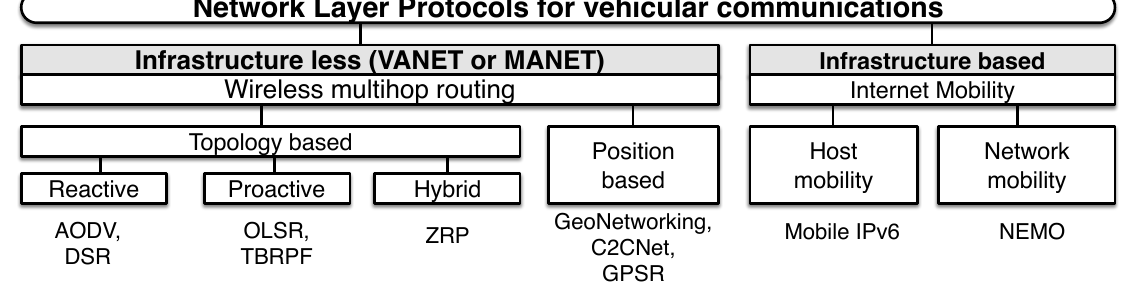
Figure 2. Network protocols in vehicular